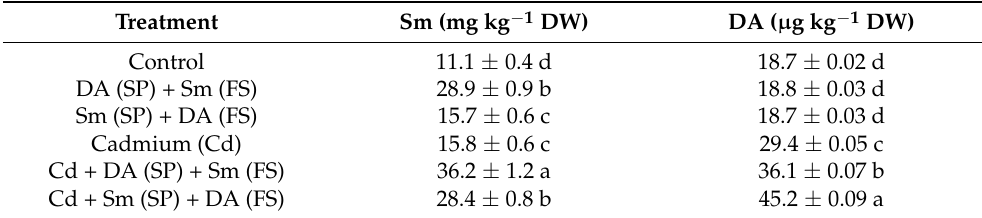
Table 1. Impacts of seed and leafy treatments with silymarin (Sm) and dopamine (DA) on Sm and DA contents of cadmium-stressed Phaseolus vulgaris